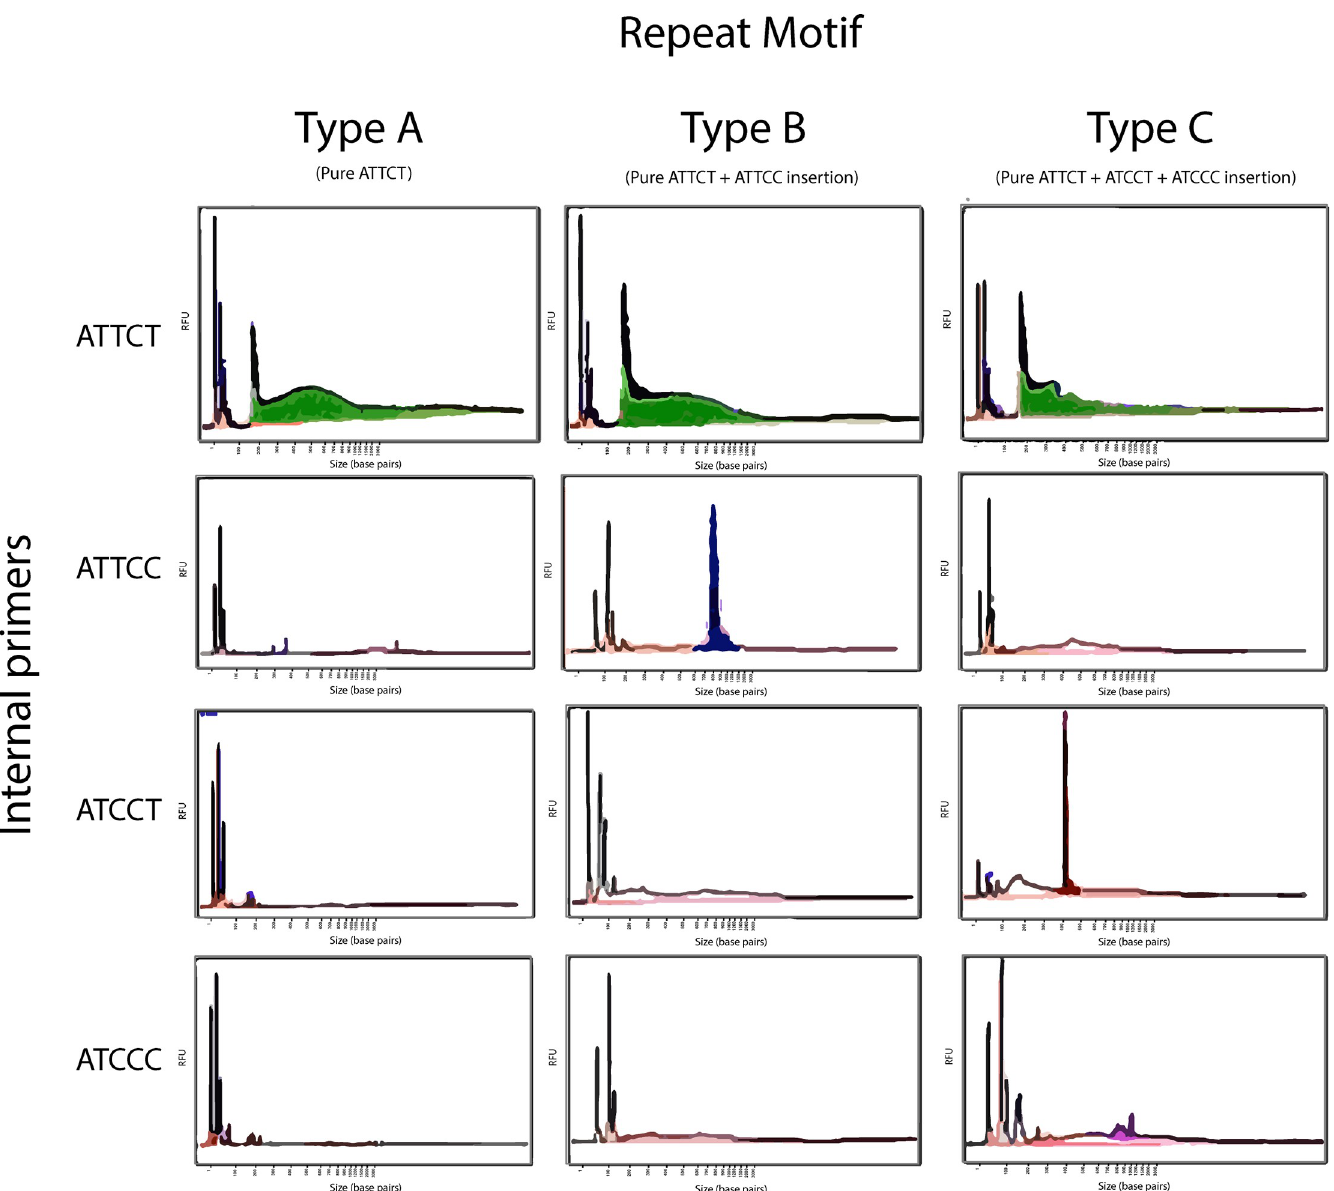
Fig 1. Typical RP-FEMTO results of the various repeat motifs. This figure shows the expected FEMTO-Pulse capillary result using the various internal primers. For the pure ATTCT repeat (Type A repeat), only the ATTCT internal primers results in prominent peaks. ATTCT repeat with an ATTCC insertion (Type B repeat) will result in a prominent peak with the ATTCT internal primer and the ATTCC internal primer. ATTCT with an ATCCT and ATCCC insertion (Type C repeat) will result in peaks with ATTCT, ATCCT and ATCCC internal